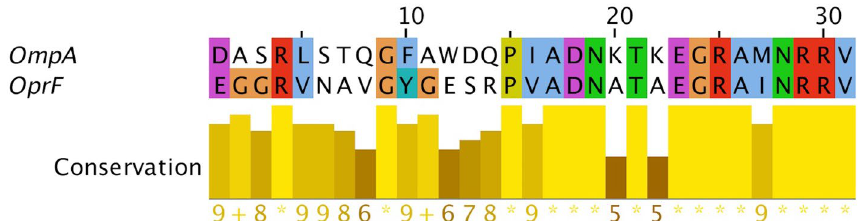
Figure 3. Alignment. The alignment of OmpA and OprF 311–341 . The alignment of the OmpA region (OmpA 301–331 ) matched to OprF 311–341 is presented in the upper panel and colored based on the ClustalX coloring scheme (31 amino acids). The lower panel illustrates the conservancy scores of each residue. The scores are from one to 10 to show the conservation level (low to high, respectively). Asterisks show identical amino acids; the plus symbols show the tiny similar amino acids. The sequences are labeled by the protein names.